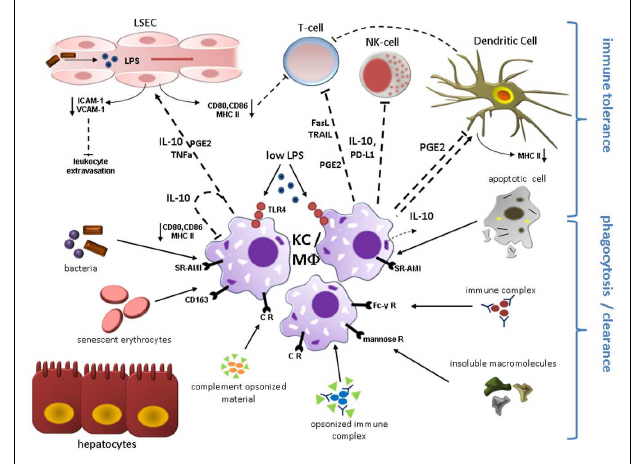
FIGURE 1 | Kupffer cell (KC)/Macrophage (M Φ ) function during liver homeostasis. Phagocytosis and induction of immune tolerance as the two main functions of KCs/hepatic M Φ in the steady state are depicted here. KCs reside in the liver sinusoids in close proximity to sinusoidal endothelial cells (LSEC) and immune cells entering the liver microvasculature mainly through the portal vein. KCs express a broad range of surface receptors mediating phagocytosis, which renders these cells as highly effective filters of endogenous and exogenous antigens. Complement receptors mediate removal of complement-opsonized material. Circulating non-opsonized immune globulin complexes are cleared through Fc- γ Receptors. Insoluble macromolecules from multiple sources are effectively cleared after binding to Scavenger Receptors including CD163 for senescent erythrocytes. Molecules with a mannosyl motif are phagocytized following engagement of mannose receptors. Engulfment of apoptotic cell constituents can induce secretion of immunosuppressive IL-10 which likely contributes to the immune modulatory function of quiescent KCs. Constant exposure to gut-derived LPS viaTLR4 also results in expression of IL-10 and PGE2 that can directly inhibitT-cell and NK-cell function and mediate down-regulation of co-stimulatory proteins including CD80, CD86, and MHC class II on endothelial cells, dendritic cells, and KCs constituting liver APCs, which further attenuatesT-cell activation. KC-secreted PD-L1 and release of apoptosis-inducing mediators (TRAIL, FasL) contribute to suppression of adaptive and innate immune response through inactivation/elimination of T-cells and NK-cells. IL-10, PGE2, andTNF-alpha lead to reduced expression of adhesion molecules (VCAM-1; ICAM-1) on LSEC, thereby limiting leukocyte influx. Abbreviations: APC, antigen presenting cell; CR, complement receptor; FasL, Fas ligand; ICAM-1, intercellular adhesion molecule 1; PD-L, programmed cell death 1 ligand 1; PGE2, prostaglandin E2; SR-AI/II, scavenger receptor AI/AII;TLR4, toll-like receptor 4;TRAIL, tumor necrosis factor related apoptosis-inducing ligand;VCAM-1, vascular adhesion molecular 1.